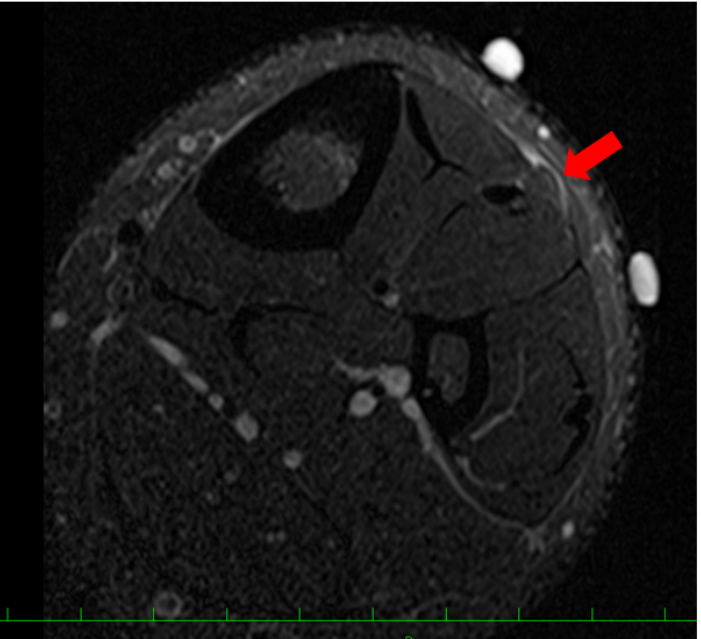
Figure 3. Preoperative magnetic resonance imaging (MRI) findings. A slightly swollen lesion (red arrow) of the tibialis anterior muscle with thin crural fascia was detected.